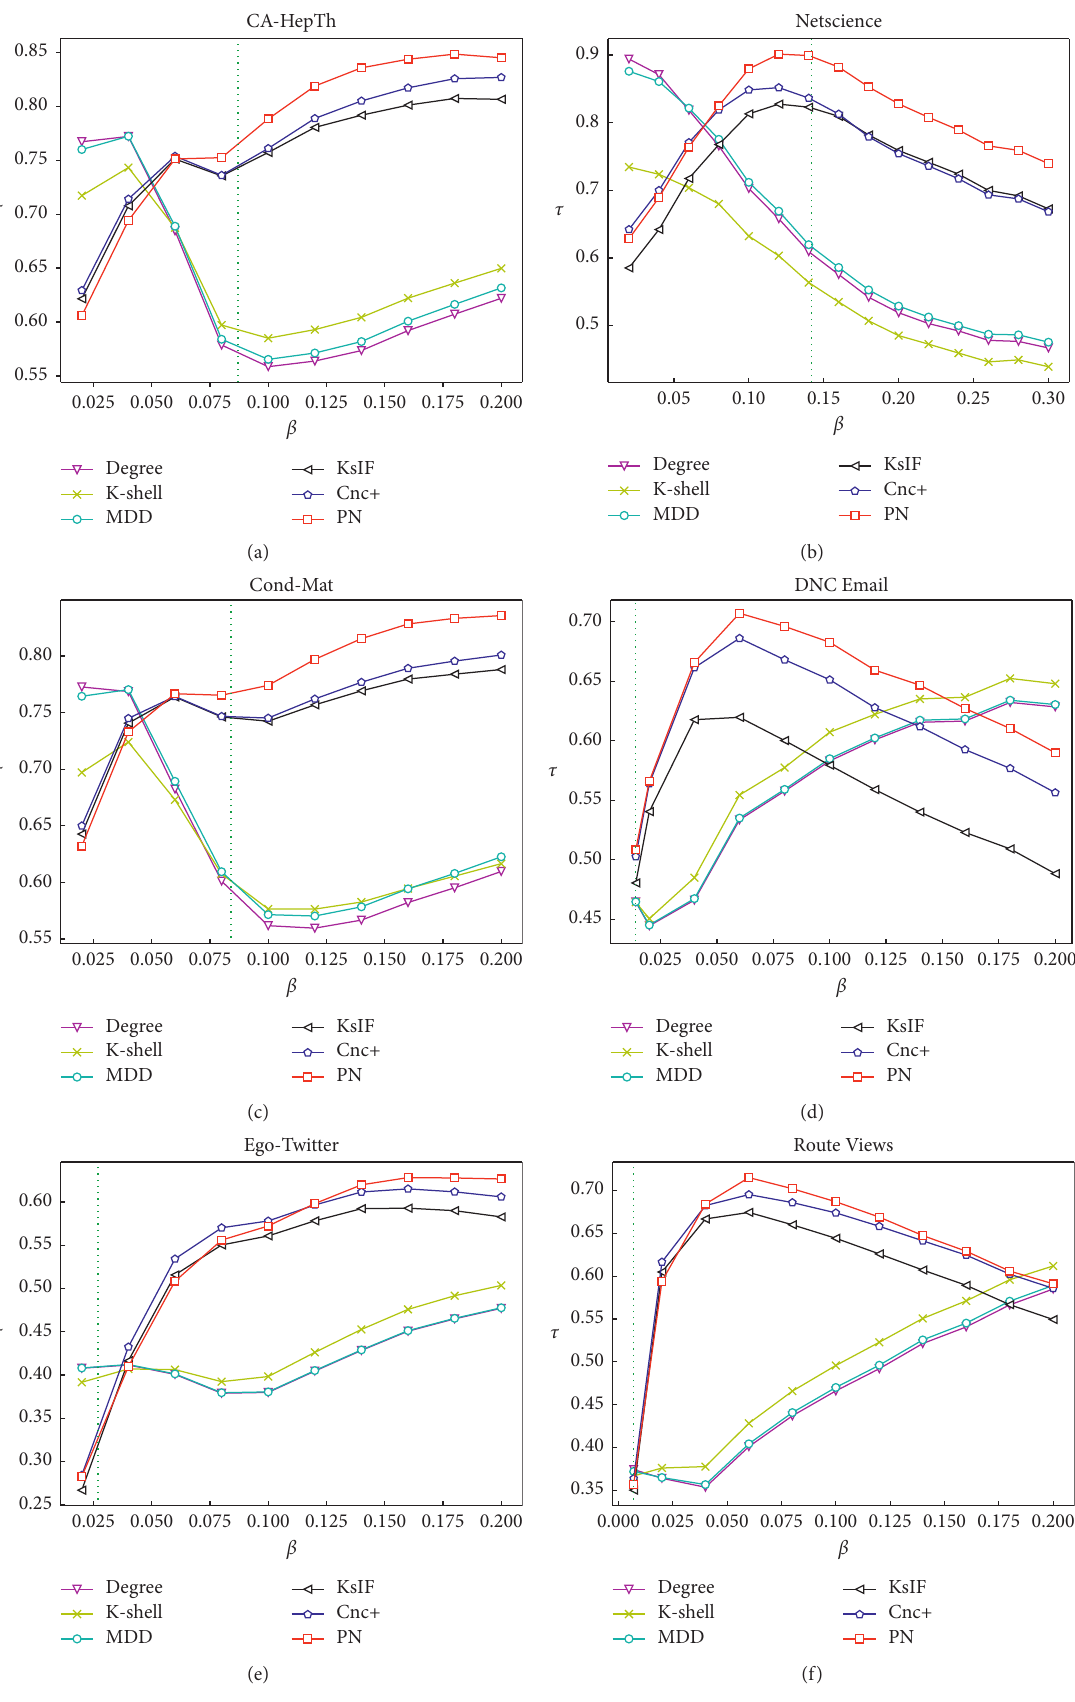
Figure 5: The correlation coefficient variation diagram of the six methods under different propagation probabilities. The experiments are simulated on six different datasets: CA-HepTh (a), Netscience (b), Cond-Mat (c), DNC Email (d), Ego-Twitter (e), and Route Views (f). The green vertical line is the epidemic threshold of the corresponding